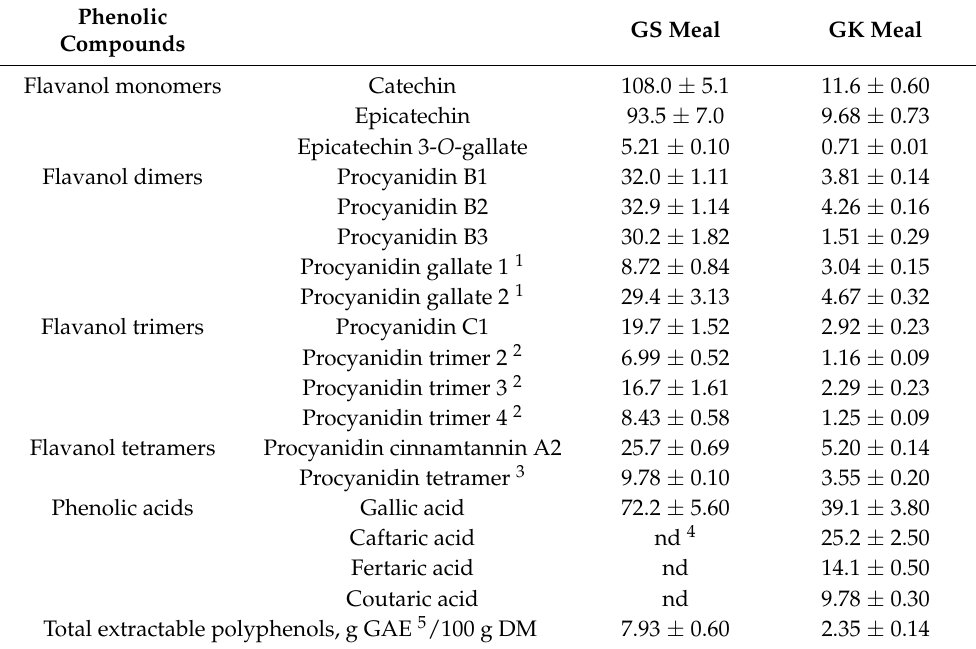
Table 2. Main extractable phenolic compounds identified in grape seed (GS) and grape skin (GK) meals expressed as mg per 100 g of DM (dry